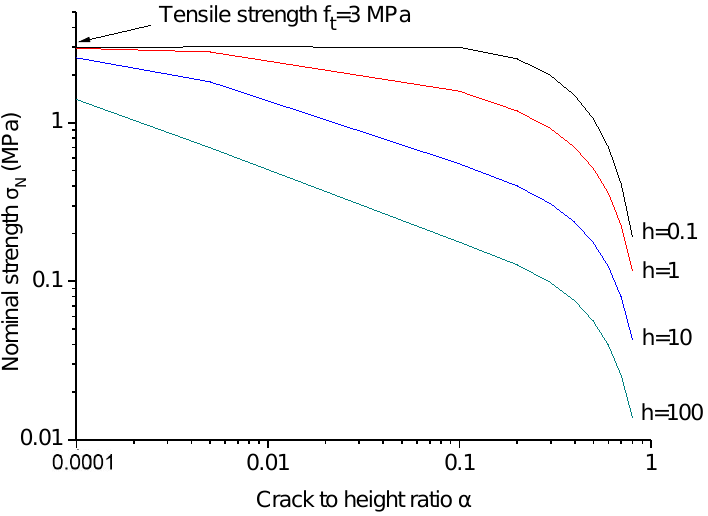
Figure 8. Nominal strengths versus the crack to height ratio α for various beam